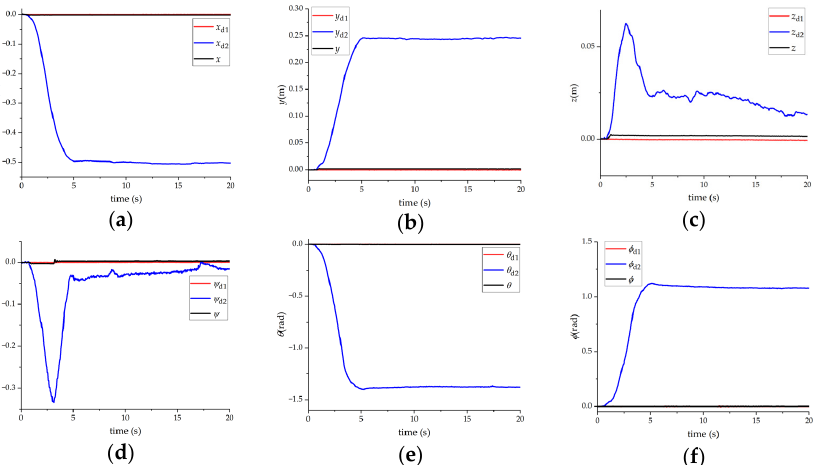
Figure 18. Pose of the VR handle and the virtual object in the second experiment: ( a ) the x component; ( b ) the y component; ( c ) the z component; ( d ) the φ component; ( e ) the θ component; and ( f ) the ψ component.